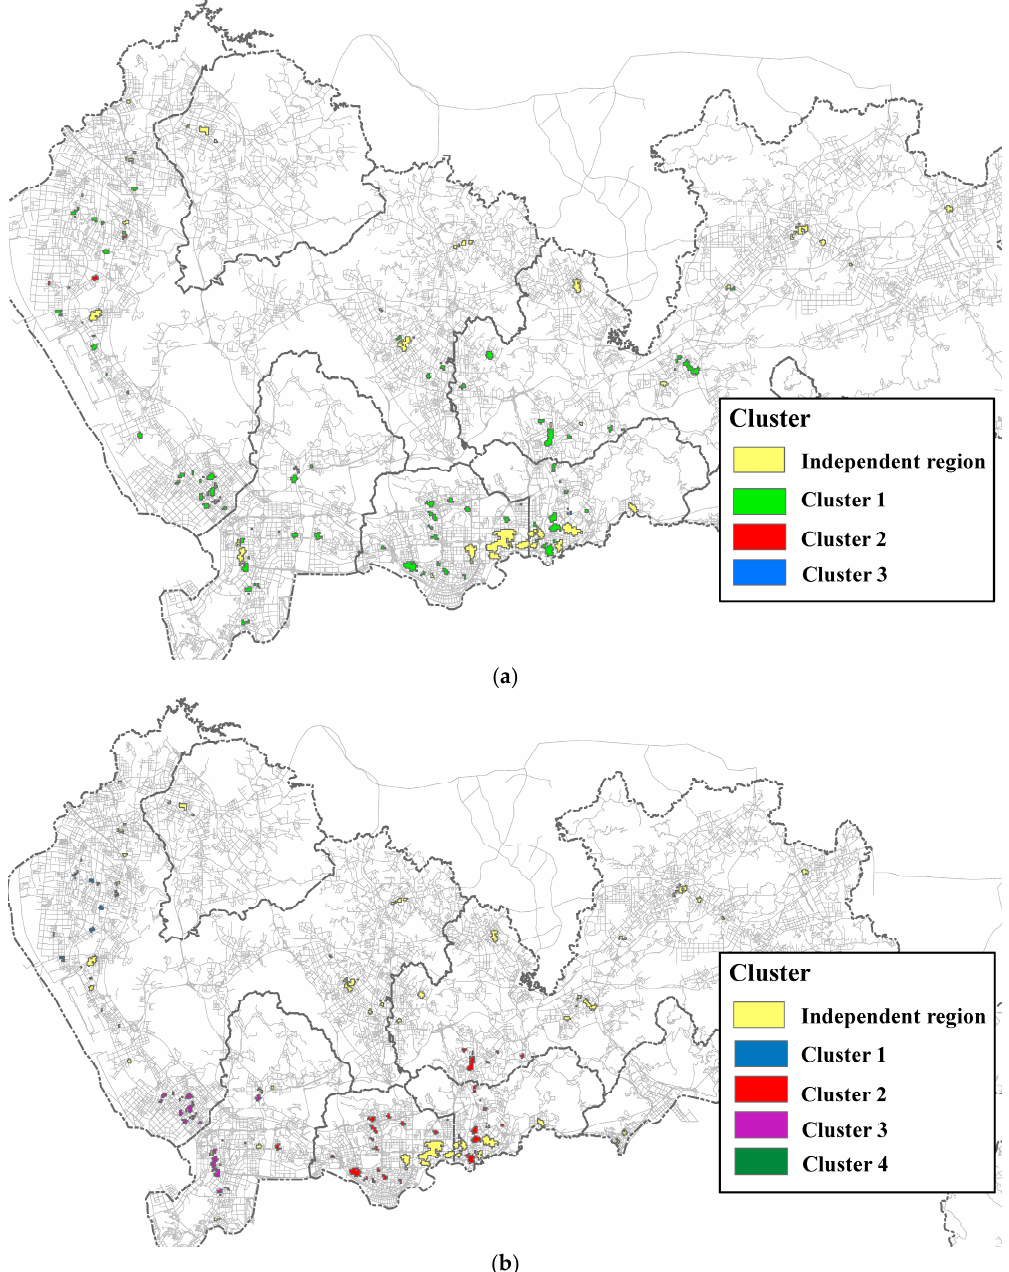
Figure 14. Results of clustering prevalent regions using the distance weights: ( a ) w H = 0.3 and w C = 0.7; and ( b ) w H = 0.7 and w C = 0.3, for the size-3 pattern {bank, retail store, hotel}. The bandwidth is 300